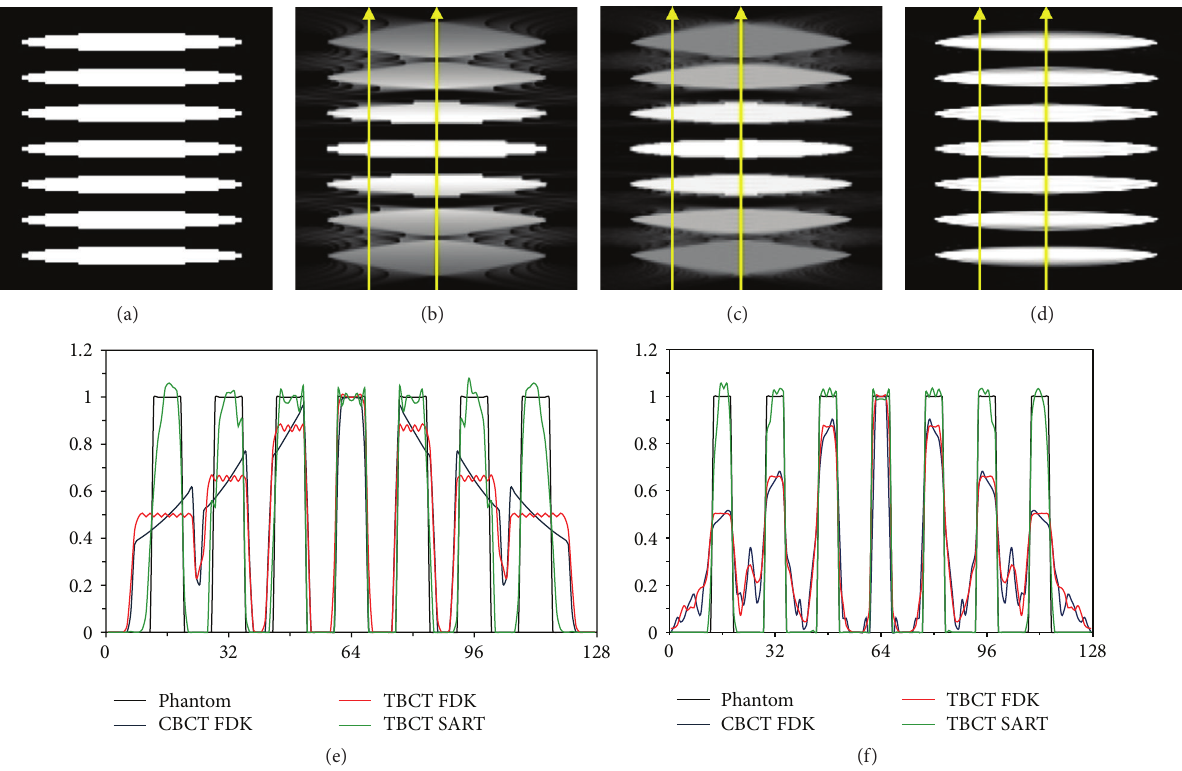
Figure 8: Comparison of reconstruction of a disk phantom with different methods. (a)–(d) Coronal views of original phantom, reconstructions using CBCT FDK, TBCT FDK, and TBCT SART methods, respectively. (e) and (f) are line profiles taken through the center and edges, respectively, of the images as indicated by the